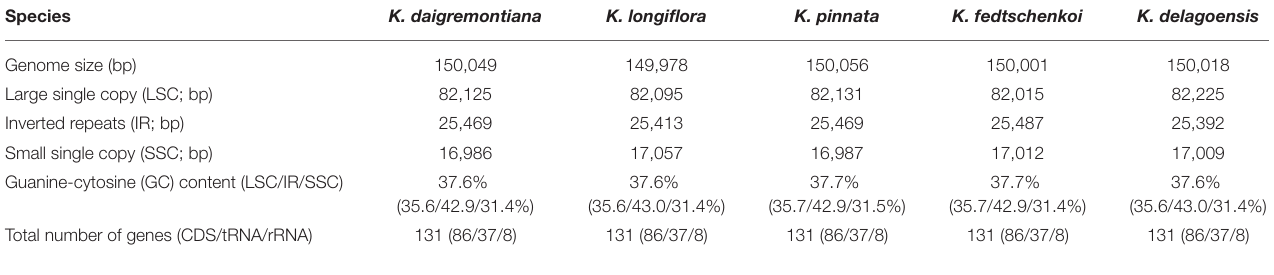
TABLE 1 | Summary statistics for the assembly of the five Kalanchoe chloroplast genomes. Species